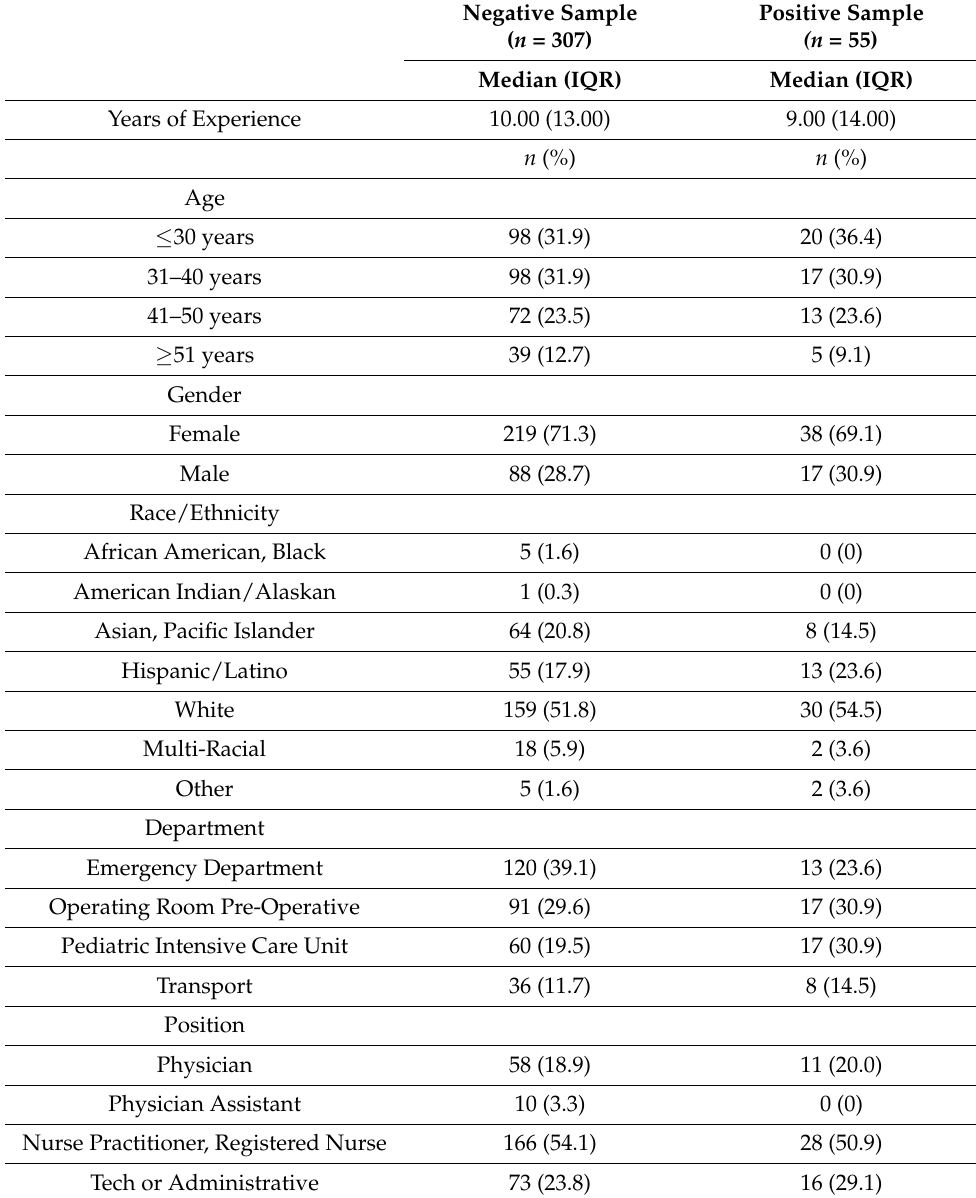
Table 1. Participant